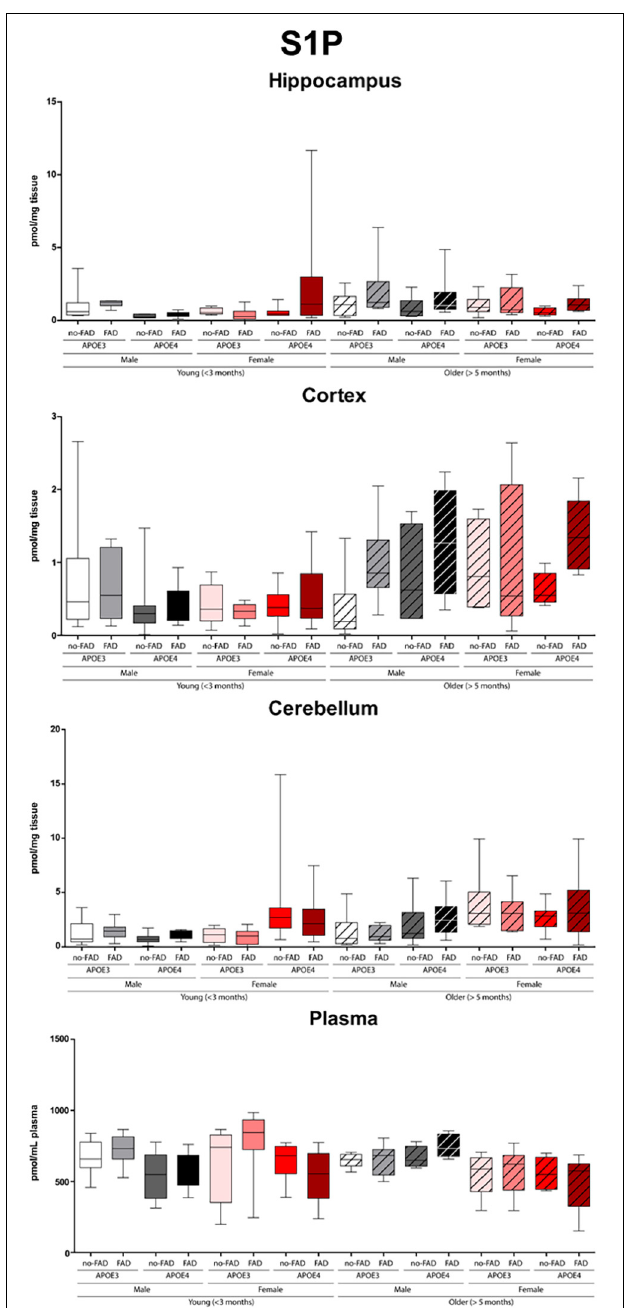
FIGURE 2 | Total determined ceramide levels in hippocampus, cortex, cerebellum, and plasma. Data are given as median (line, box dimensions 25th–75th percentile, whiskers min–max) in pmol/mg tissue or pmol/mL plasma ( n = 7–10 mice per group for brain samples and n = 4–10 per group for plasma